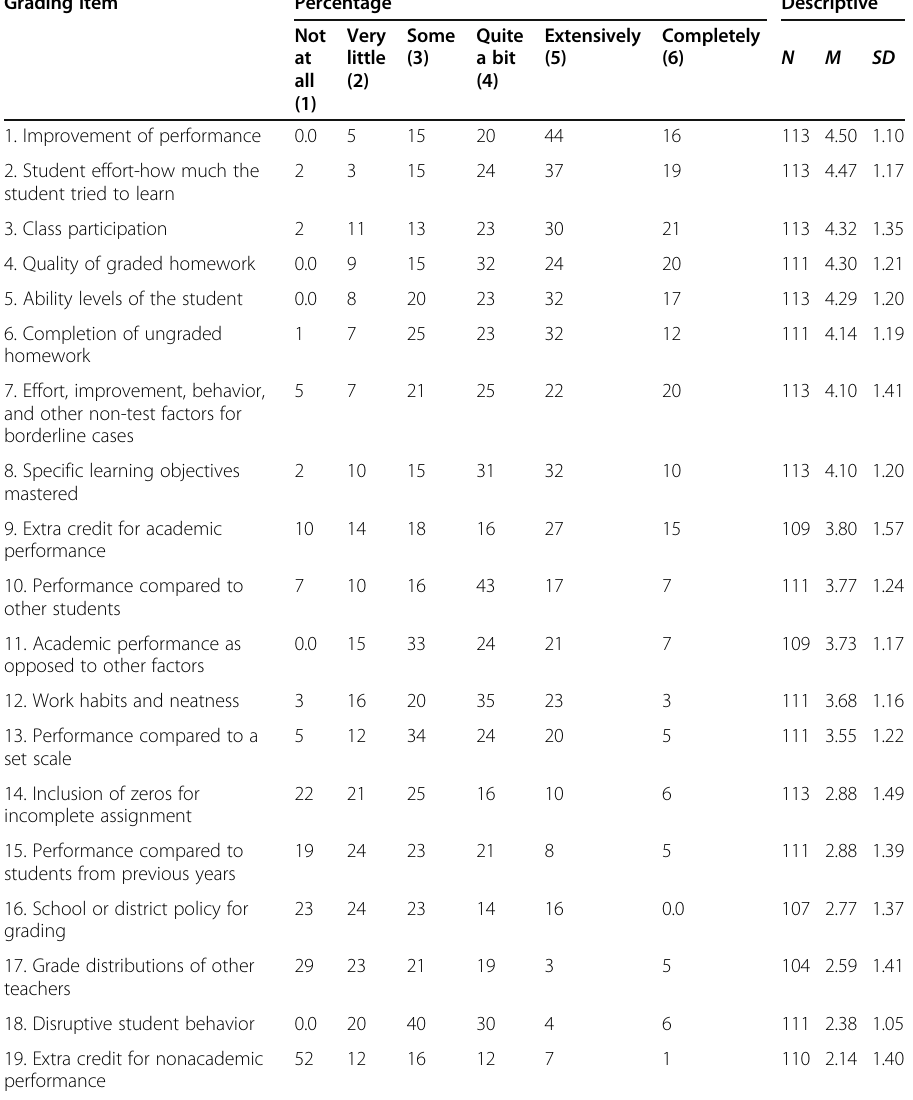
Table 3 Descriptive statistics of grading items used by private EFL institute